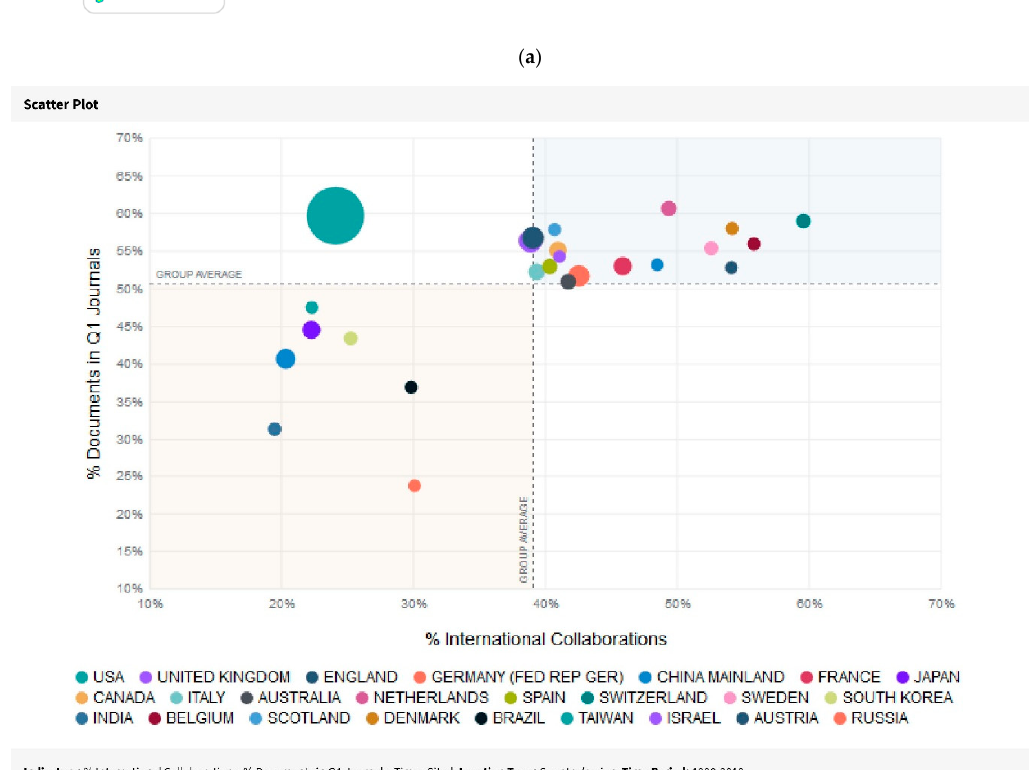
Figure 5. ( a ) Top 25 Co-authorship analysis (countries). The relatedness of items is determined based on their number of co-authored documents. Minimum number of documents of a country (5) and minimum number of citations of a country (5). ( b ) InCites Top 25 Locations and Record Count.